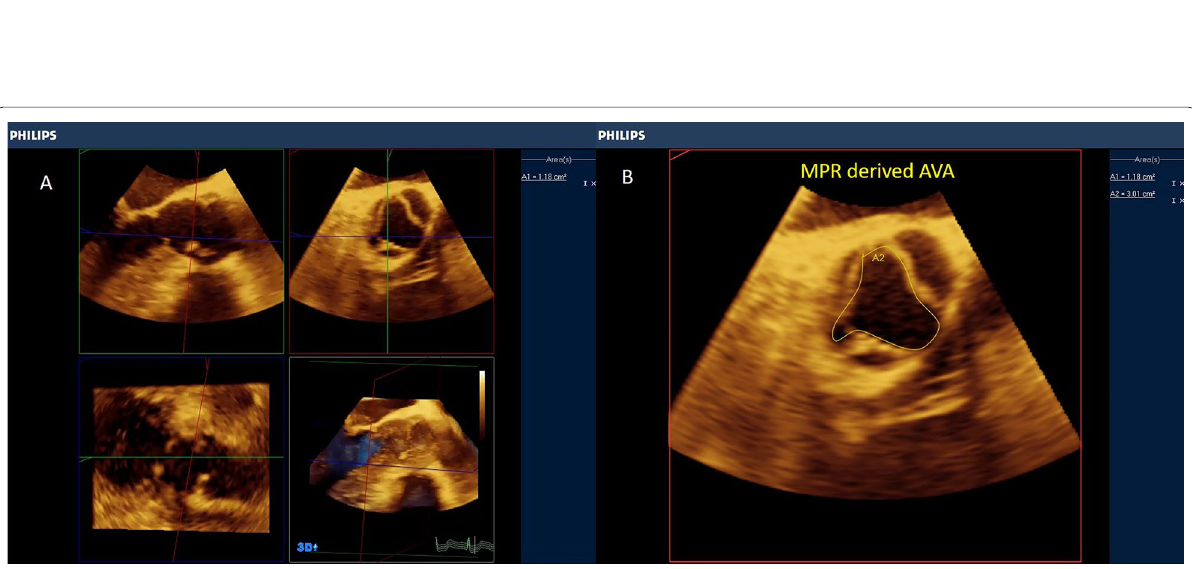
Fig. 6 Multiplanar reformatting (MPR) of the 3D volume of the aortic valve. (panel A) Direct planimetry of the narrowest AV orifice was obtained (Panel